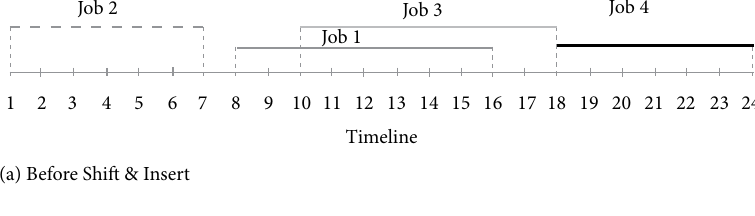
(a) Before Shift & Insert